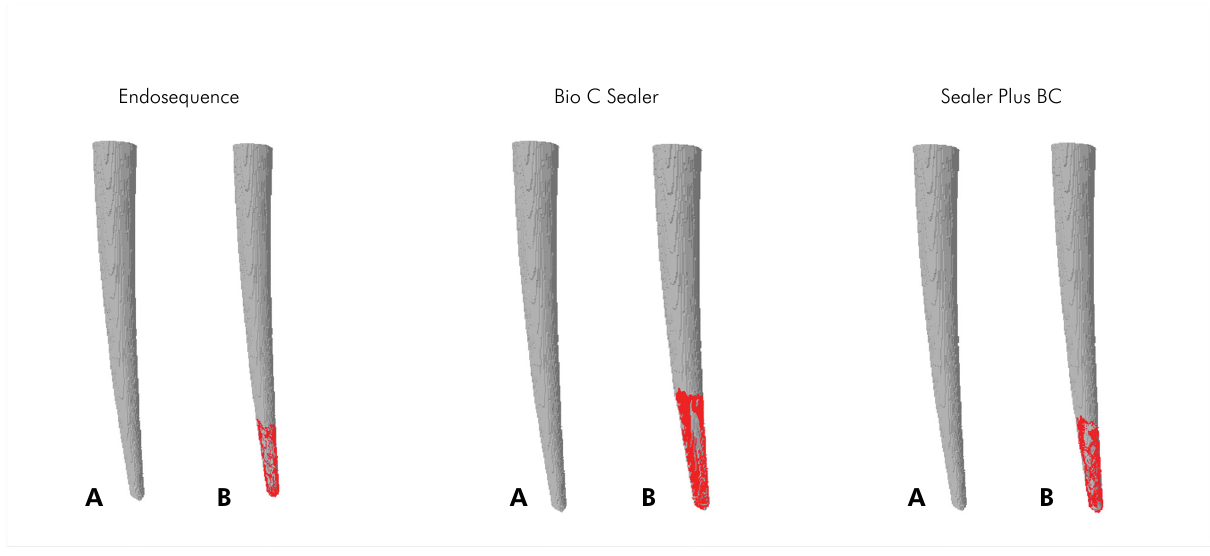
Figure 2. Representative images of volumetric change of materials. A) material in the initial scan and B) change in volume after 168 h.